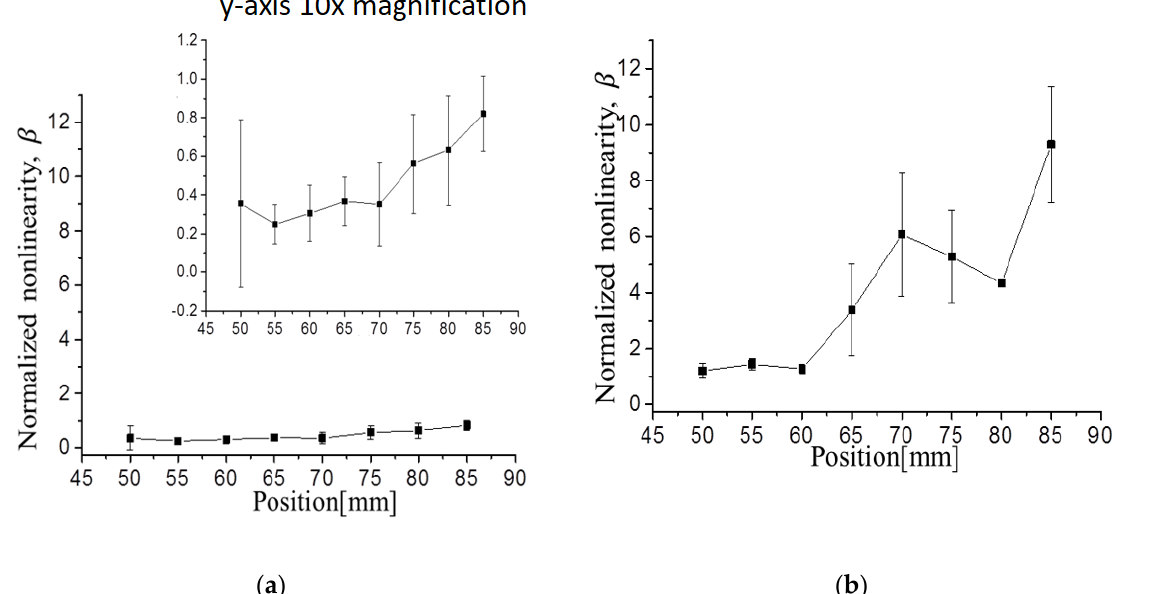
Figure 15. Nonlinearity variation depending on the receiver position with the same vertical range: ( a ) Phase matching mode; ( b ) Guided wave mixing.